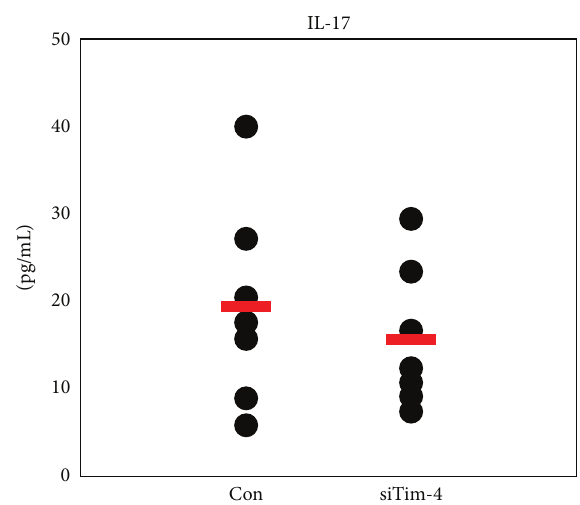
Figure 10: Administration of siTim-4 decreased serum level of IL- 17 in Behc¸et’s disease (BD) mice. Serum obtained at 2 weeks after the first injection of siTim-4 and control (Con) in BD mice. The level of IL-17 was analyzed by ELISA ( 𝑛 = 8 ). Con: negative control siRNA injection to BD mice, siTim-4: Tim-4 siRNA injection to BD mice.